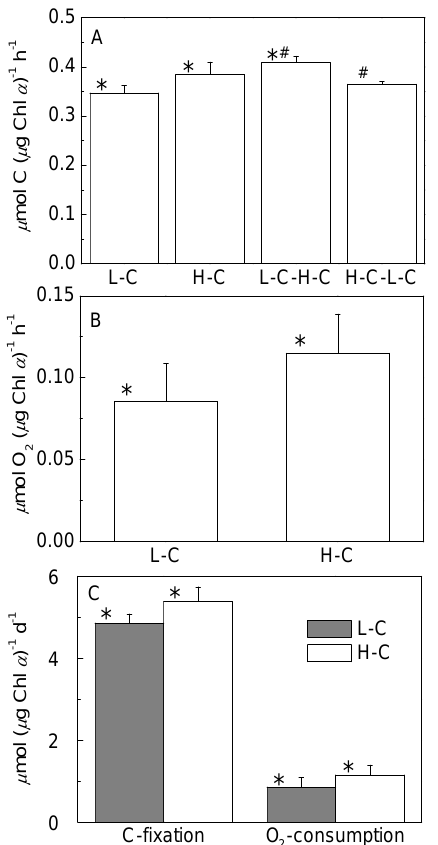
Fig. 2. (A) Photosynthetic carbon fixation, (B) dark respiration, and (C) integrated daily photosynthetic carbon fixation and dark respira- tion of low (L-C) and high CO 2 grown cells (H-C), low CO 2 grown cells measured in high CO 2 (L-C-H-C) and high CO 2 grown cells measured in low CO 2 (H-C-L-C); vertical bars represent SD, n =9– 12 for carbon fixation and 3–5 for oxygen consumption. An asterisk and a number sign “#” represent significant difference among treat- ments ( p < 0.05).